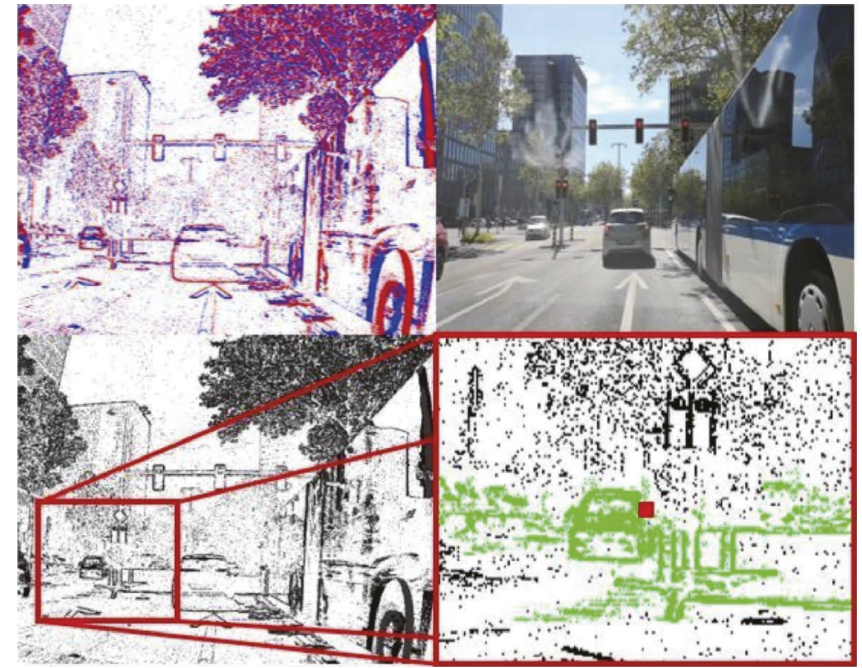
Figure 22: Te event-based